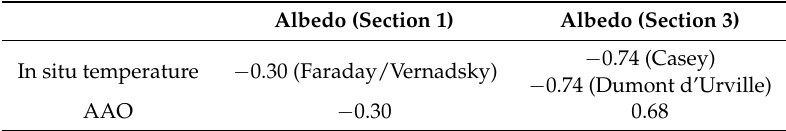
Table 2. Correlation coefficient between albedo and climatic variables at each